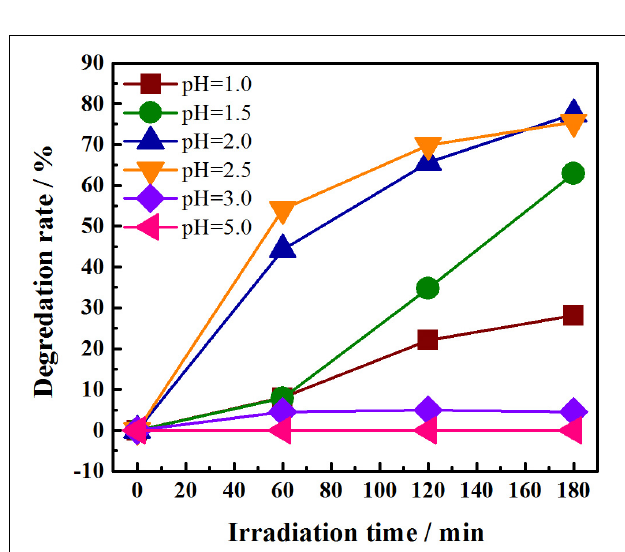
FIGURE 6 | Degradation rates of EBFS-1180 ceramics against RhB at different